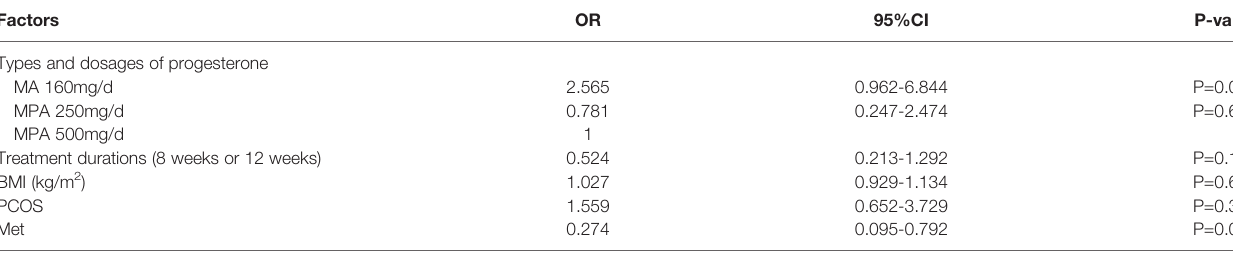
TABLE 3 | Multivariate analysis of potential confounders associated with the treatment response.